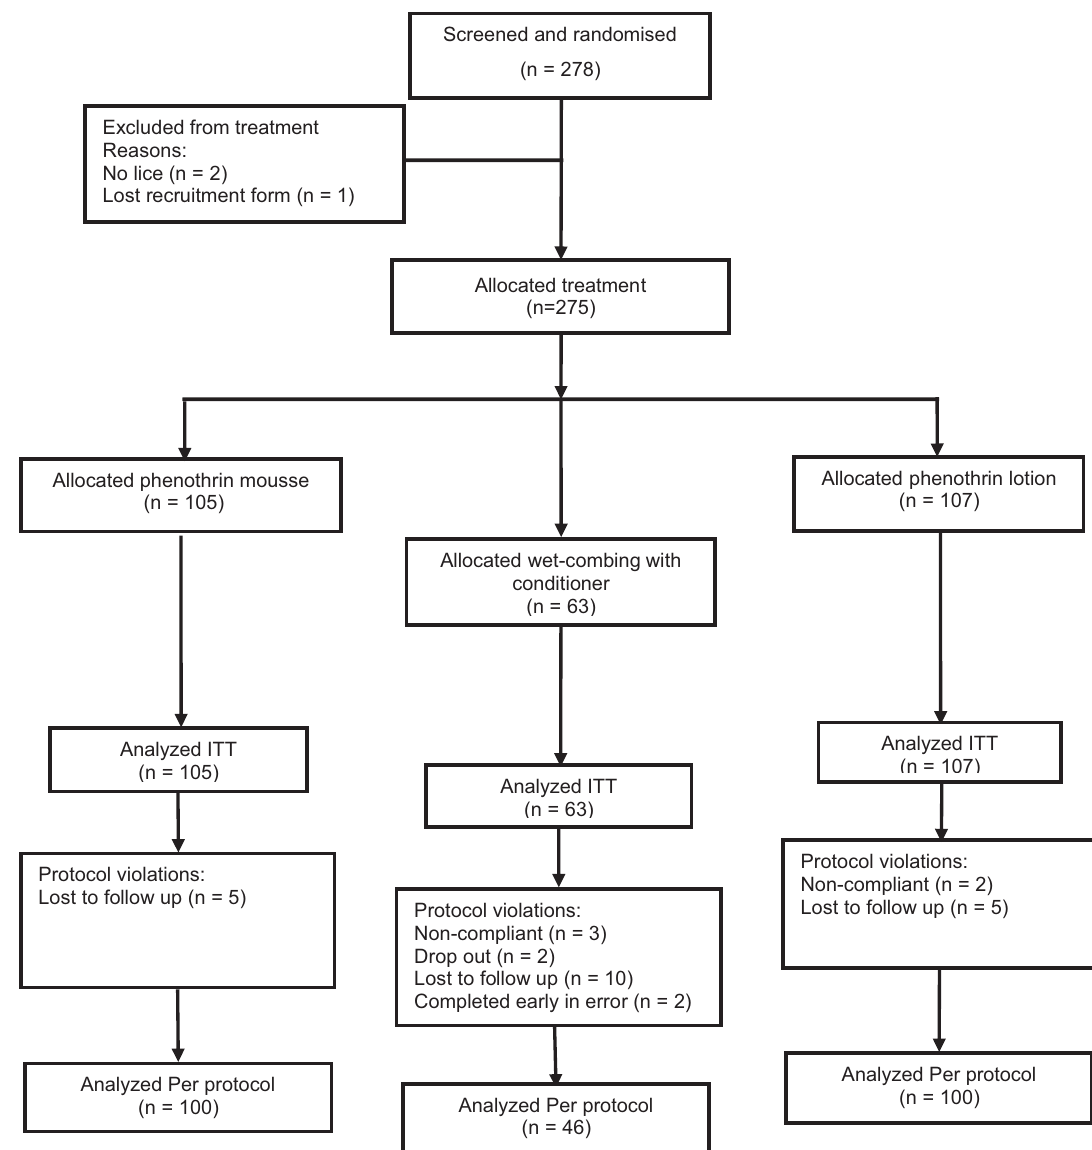
Figure 1. Flowchart of participants through the study. involved additional combing or other unauthorised treatments (2 receiving lotion and 2 wet-combing) and one participant on wet- combing shaved his head. There were 24 other withdrawals: 2